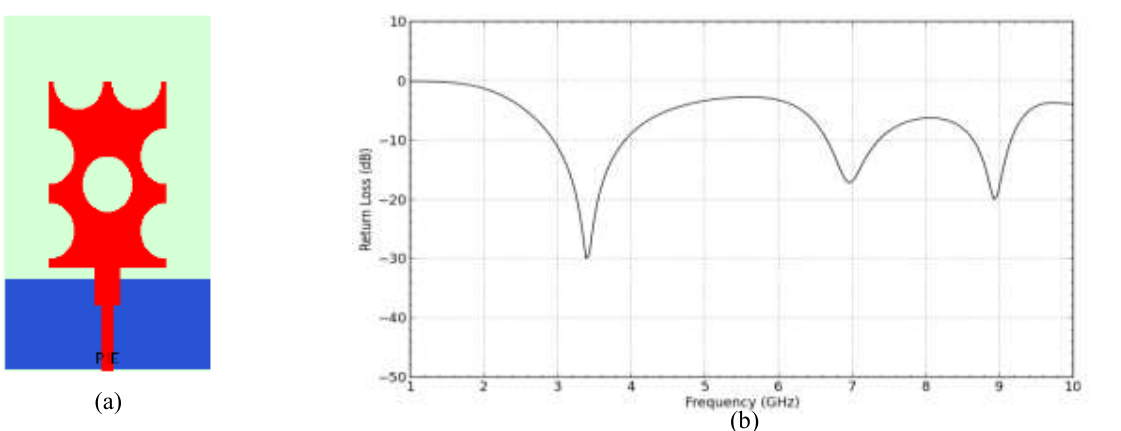
Figure 3: (a) Circular slotted patch antenna and (b) its return loss